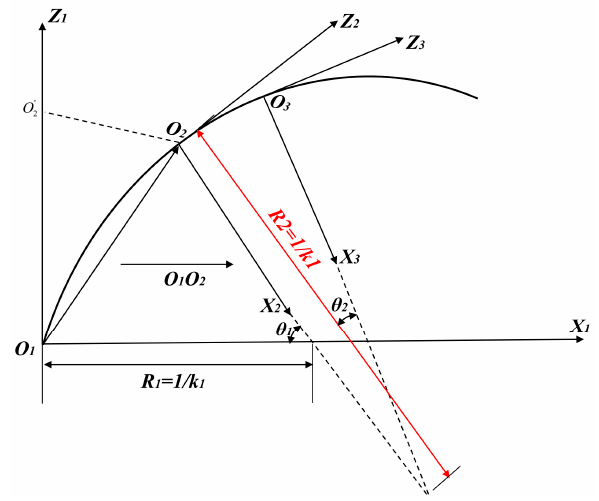
Figure 6. The algorithm of 3D shape reconstruction.